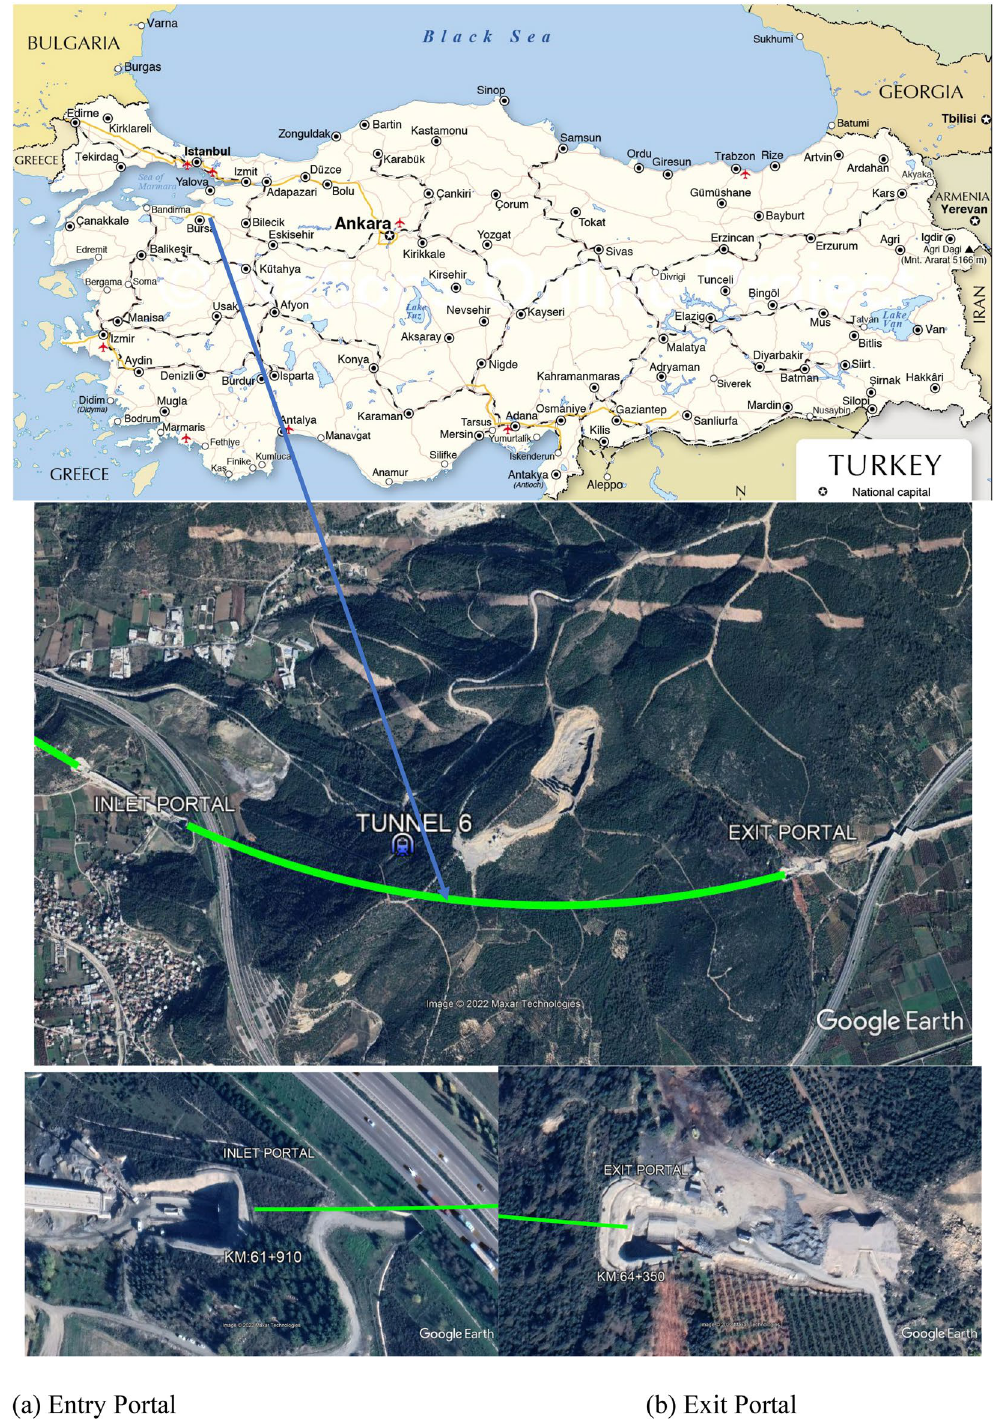
Figure 1. Location map of the T6 tunnel (National Online Project, https:// www. natio nsonl ine. org/ onewo rld/ map/ turkey- map. htm) and its entry and exit portals on Google Earth view (the Google earth pro 7.3.4.6442